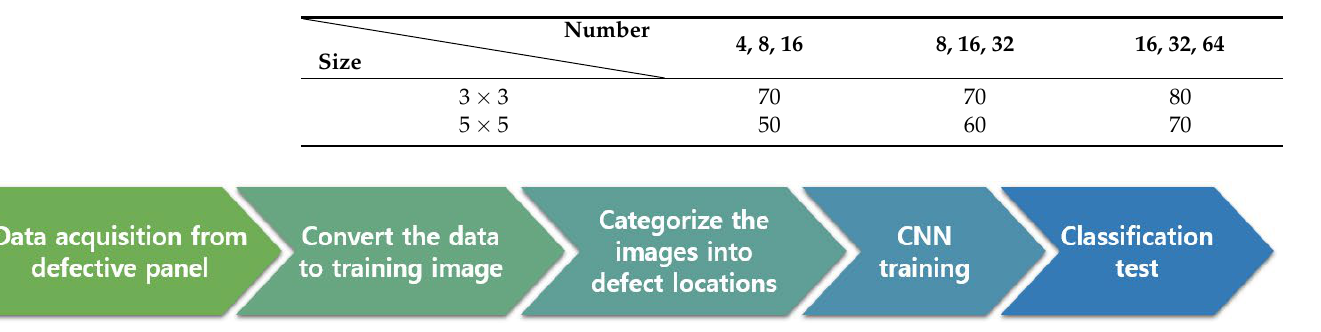
Figure 19. Convergence curve of CNN model with 50 epochs. Table 8. Testing accuracy.